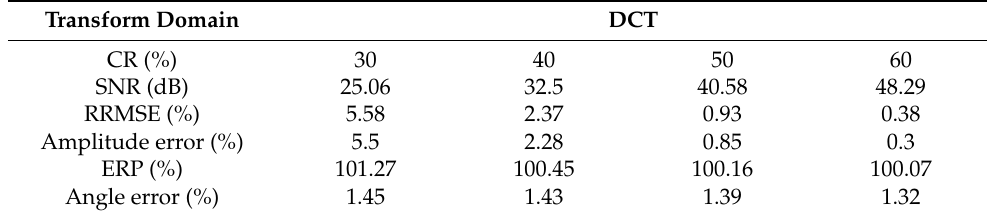
Table 2. Reconstruction results of harmonic signals in the DCT domain.